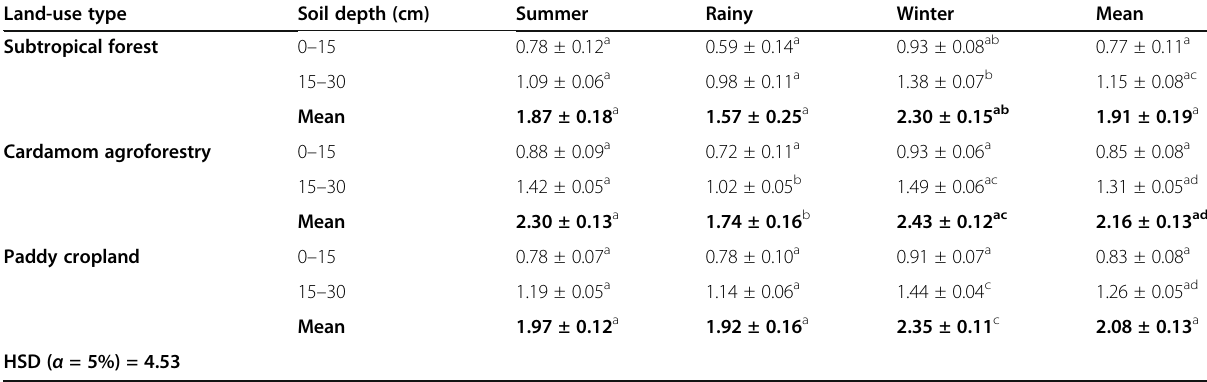
Table 5 Soil microbial quotient (MBC/SOC) % in different land-use types of Eastern Himalayas. Means ± SE sharing the same letter are not statistically different by HSD test at 5% level of confidence Land-use type Soil depth (cm)